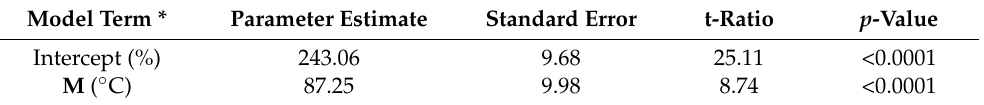
Table 6. Significant terms, estimates, and regression details of the elongation at break ( ε ) model. Model Term * Parameter Estimate Standard Error t-Ratio p -Value Intercept (%) 243.06